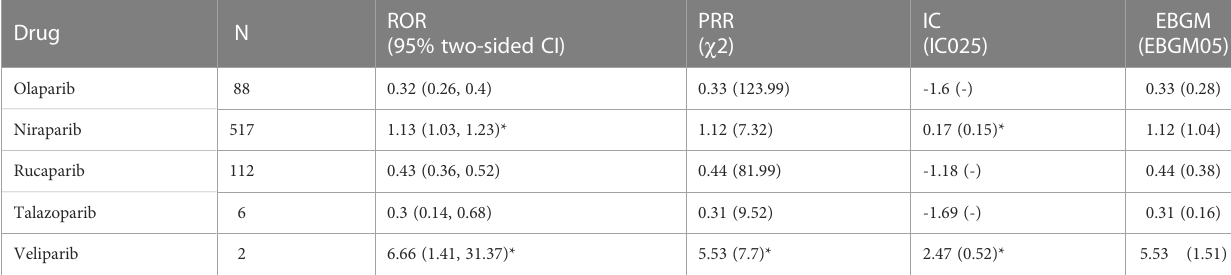
TABLE 6 Disproportionality analysis in FAERS database.